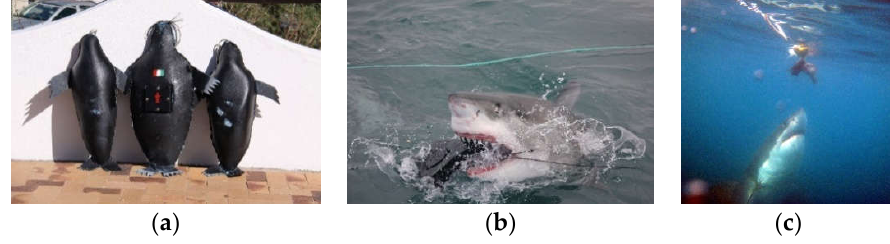
Figure 2. ( a ) Decoys, ( b ) interaction shark versus seal-shaped decoy, and ( c ) tuna bait